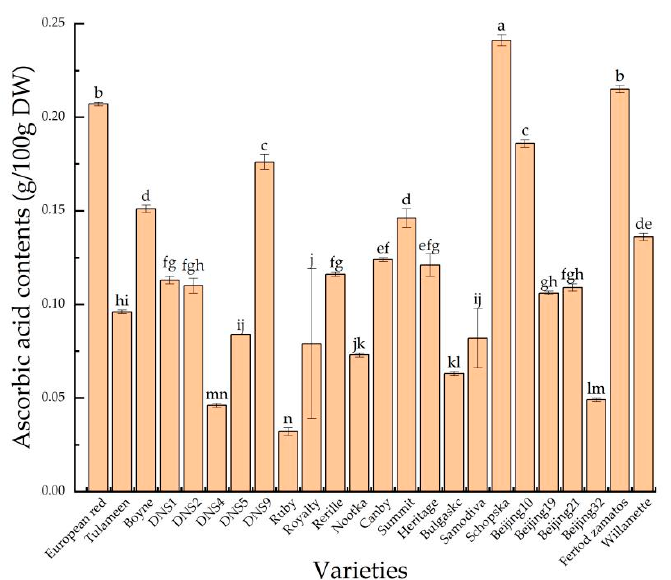
Figure 3. The ascorbic acid contents of 24 red raspberry varieties. Values are given as the mean ± standard deviation ( n = 3), and the different letters were significantly different ( p < 0.05).